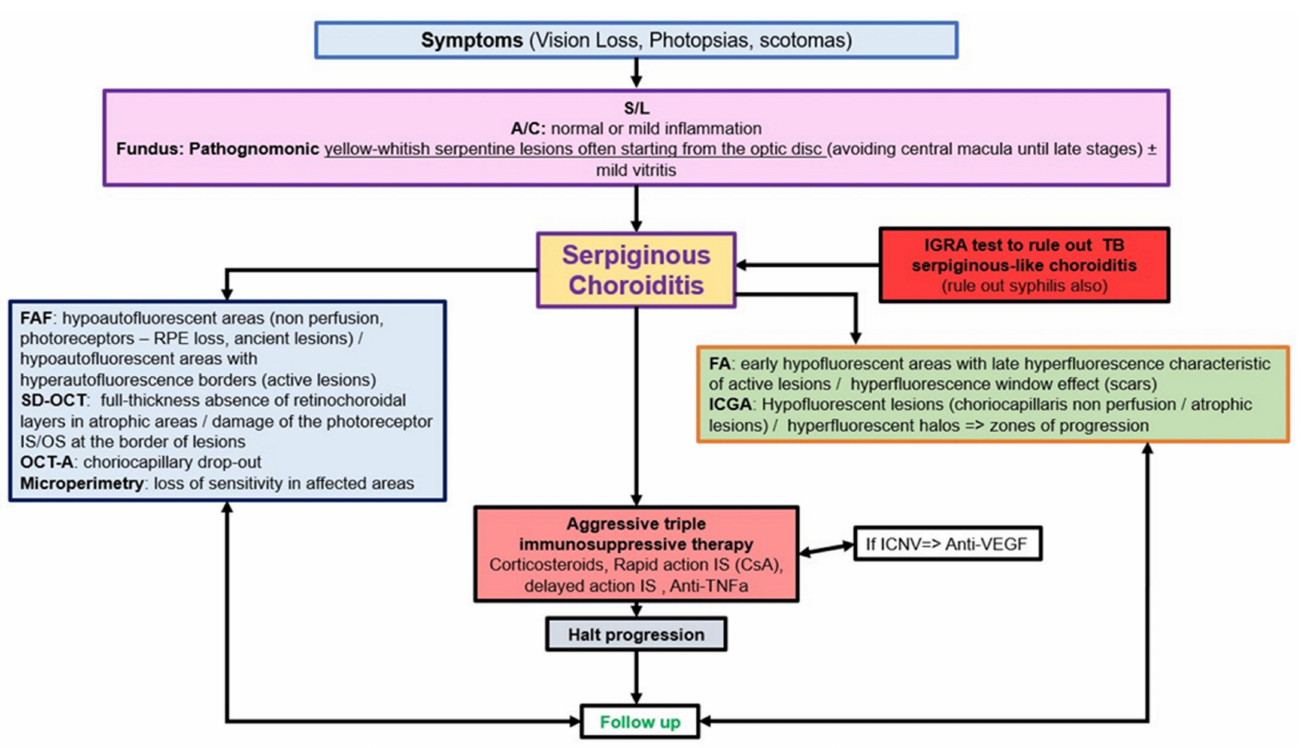
Scheme 4. Appraisal of serpiginous choroiditis: decision tree in clinical practice. S/L: slit lamp. A/C: anterior chamber. IGRA: Interferon Gamma release assays. FAF: autofluorescence. SD-OCT: spectral domain optical coherence tomography. OCT-A: OCT-angiography. VF: visual fields. FA: fluoresceine angiography. ICGA: indocyanine green angiography. TB: tuberculosis. MFC: multifocal. APMPPE: acute posterior multifocal posterior placoid epitheliopathy. CNS: central neural system. Anti-VEGF: anti-vascular endothelial growth factor. ICNV: inflammatory choroidal neovascularization. IS: immunosuppressors. CsA: cyclosporine. Anti-TNFa: anti-tumor necrosis